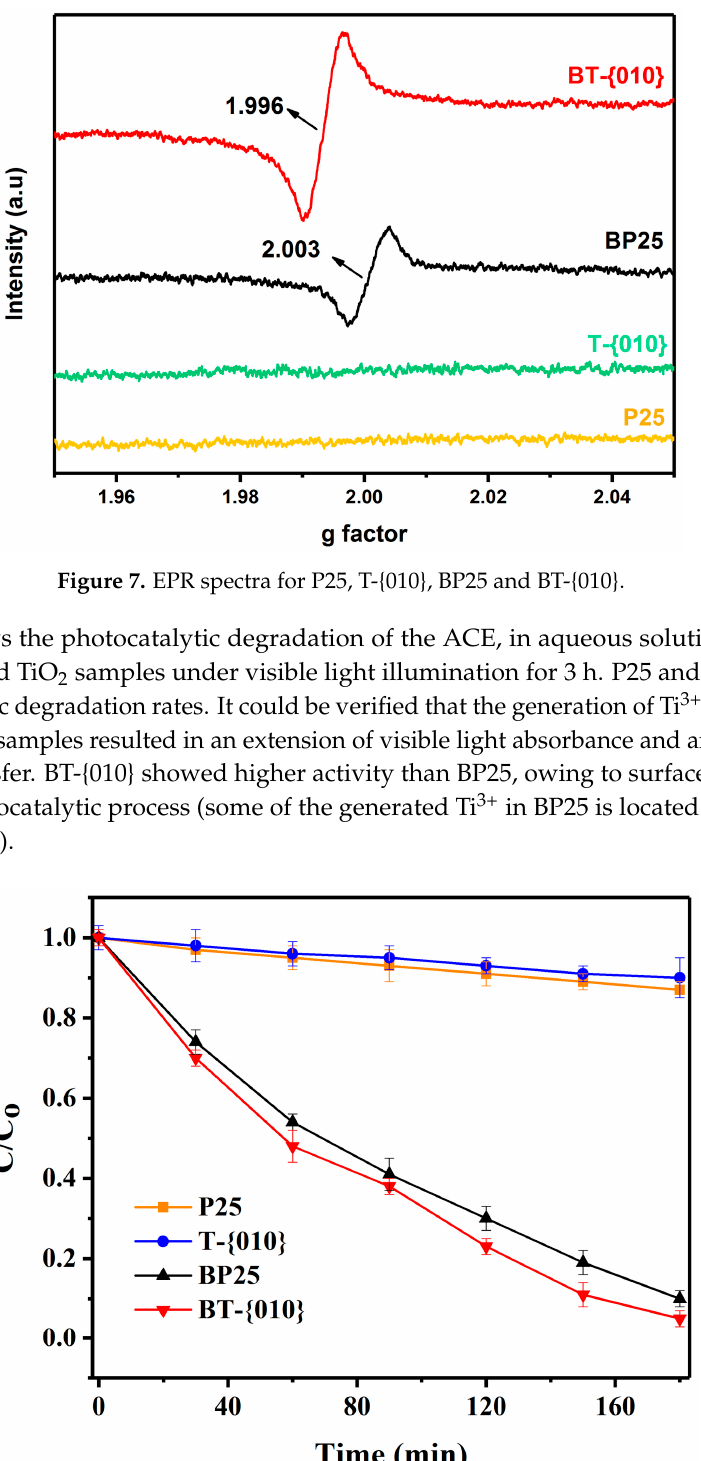
Figure 8. The photocatalytic degradation of ACE in aqueous solution by various pristine and colored TiO 2 samples under visible light illumination.